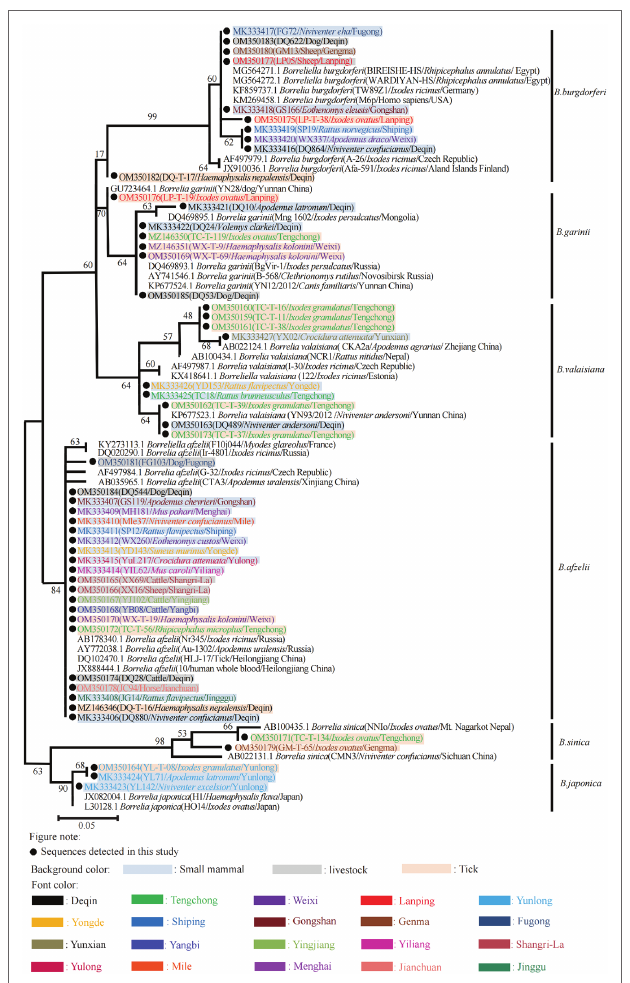
FIGURE 3 | Phylogenetic tree of 252 bp of 5S-23S rRNA intergenic spacer gene. Maximum likelihood phylogenetic tree based on a comparison of Borrelia burgdorferi sensu lato 5S-23S rRNA intergenic spacer gene sequences obtained from Yunnan small mammals/live stocks/ticks with Borrelia burgdorferi sensu lato reference strains. The number on each branch shows the percent occurrence in 5000 bootstrap replicates. Black circles stood for sequences identified in this